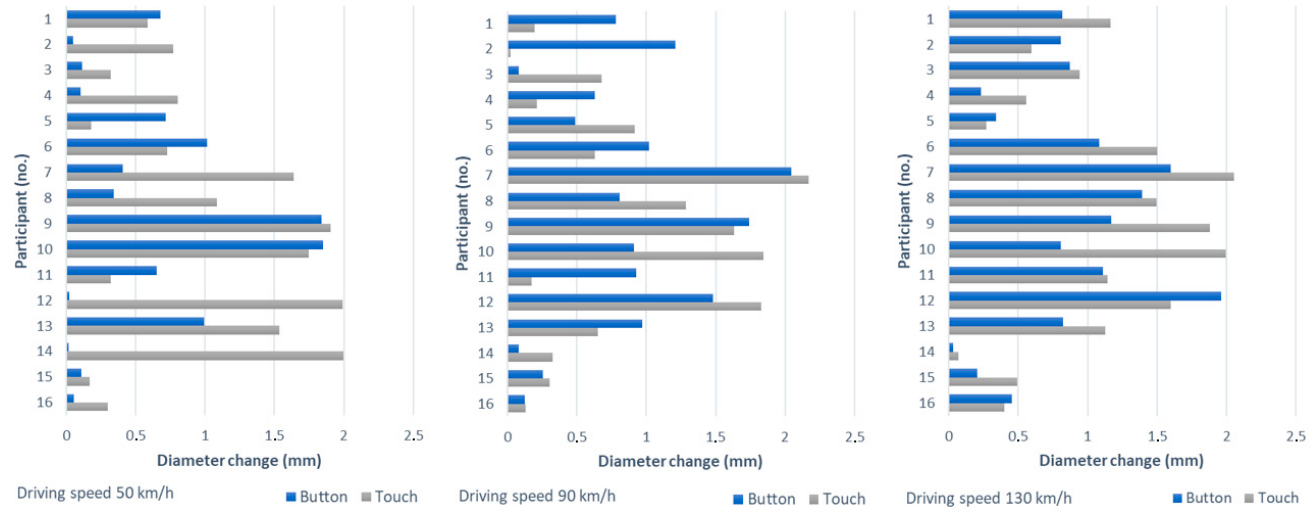
Figure 6. Pupil diameter change.